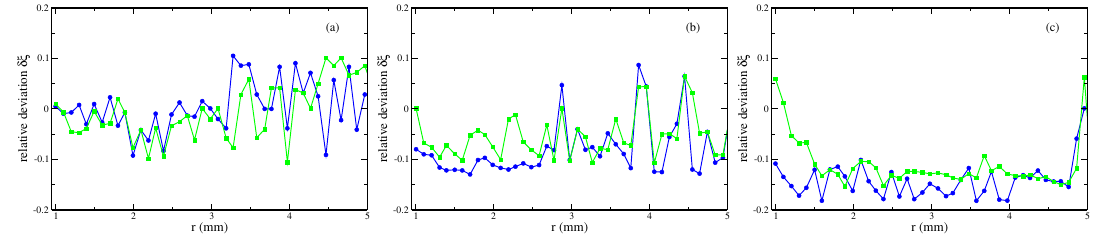
Figure 10. Relative deviation δξ , see Equation (8), of the numerically calculated menisci of the magnetic fluid APG S21 using a nonlinear law of magnetisation ( • ) and a linear law with χ = 0.65 ( (cid:4) ). ( a ) H = 3.35 kA/m, ( b ) H = 7.54 kA/m and ( c ) H = 11.73 kA/m at R = 0.95 mm. The lines are guides for the